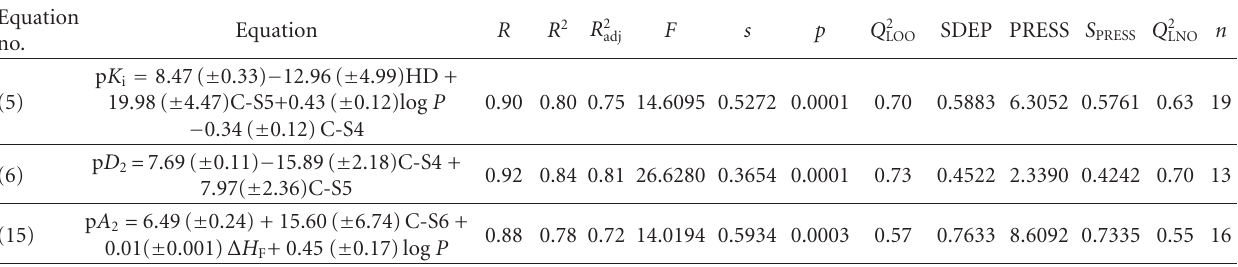
Table 5: QSAR statistics of significant